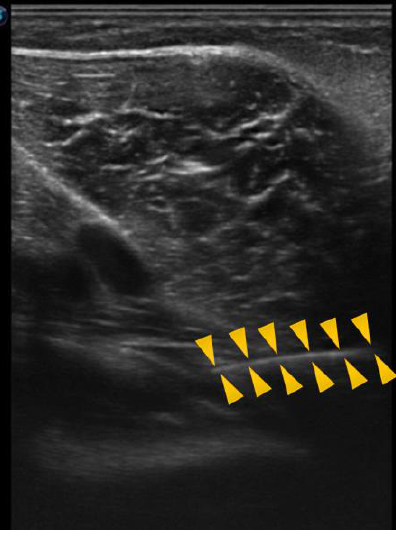
Figure 6. Ultrasound of the popliteal puncture in the internal superior region. Head arrows define the needle line. the needle line.